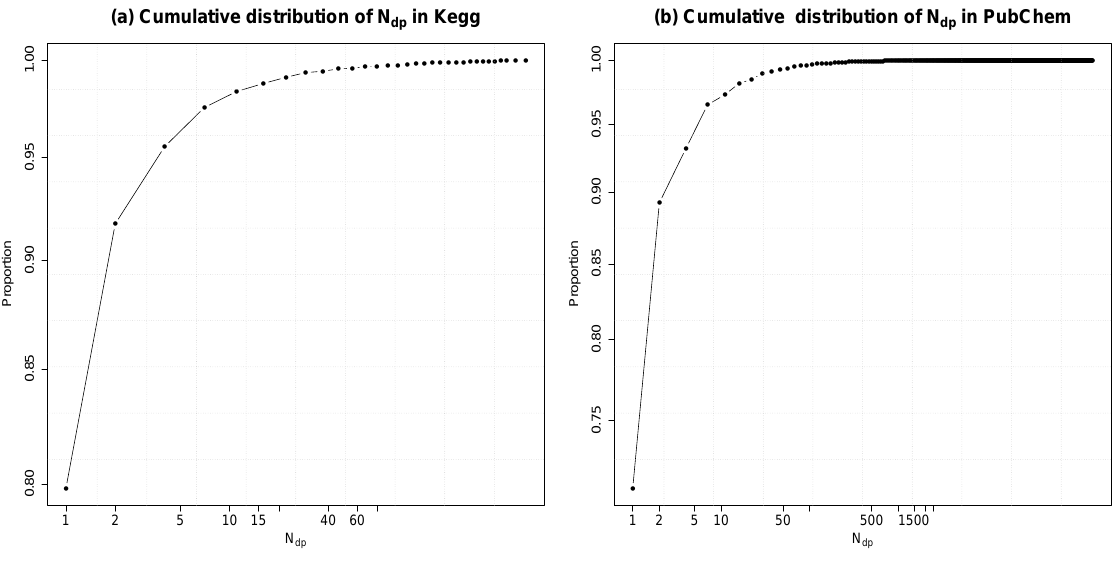
Figure 7. Cumulative distribution of N duplicates or less. Both x-axis and y-axis are in log